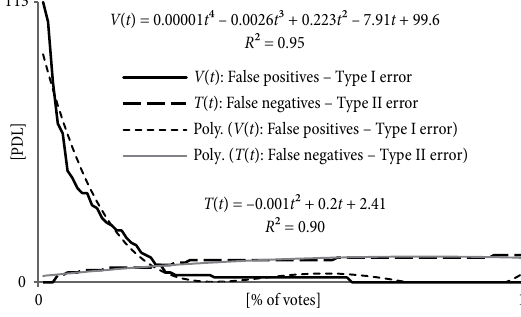
Fig. 4. Data fitting for T ( t ) and V ( t ) with the polynomial regression